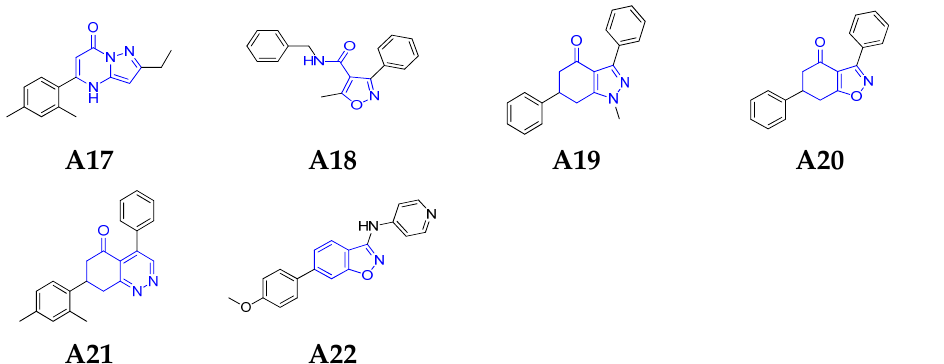
Figure 3. Examples from the designed compound library (all compounds are presented in the Supplementary Materials) consisting of 22 chemotypes derived from ADX71743 or MMPIP tool compounds (cores outlined in blue) ( A1 – A22 ). Structures A14 – A17 generated via Cresset field methodology. Initially, the terminal groups present in the reference structures were used to substitute